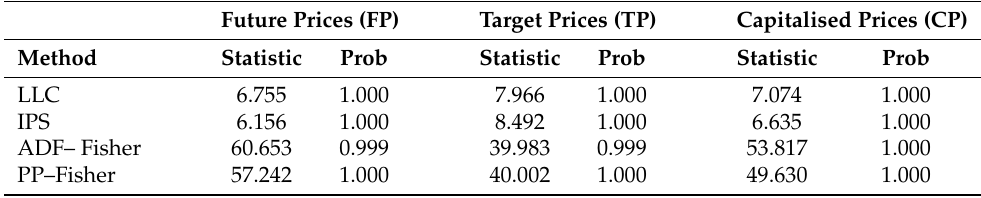
Table 2. Panel unit root test